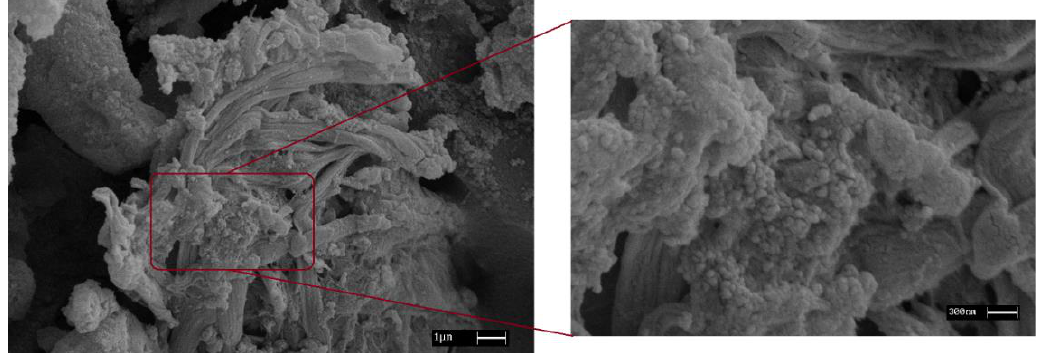
Figure 4. Magnification of a SC@Fe 3 O 4 microcrystal (scale: 1 µm and 300 nm).